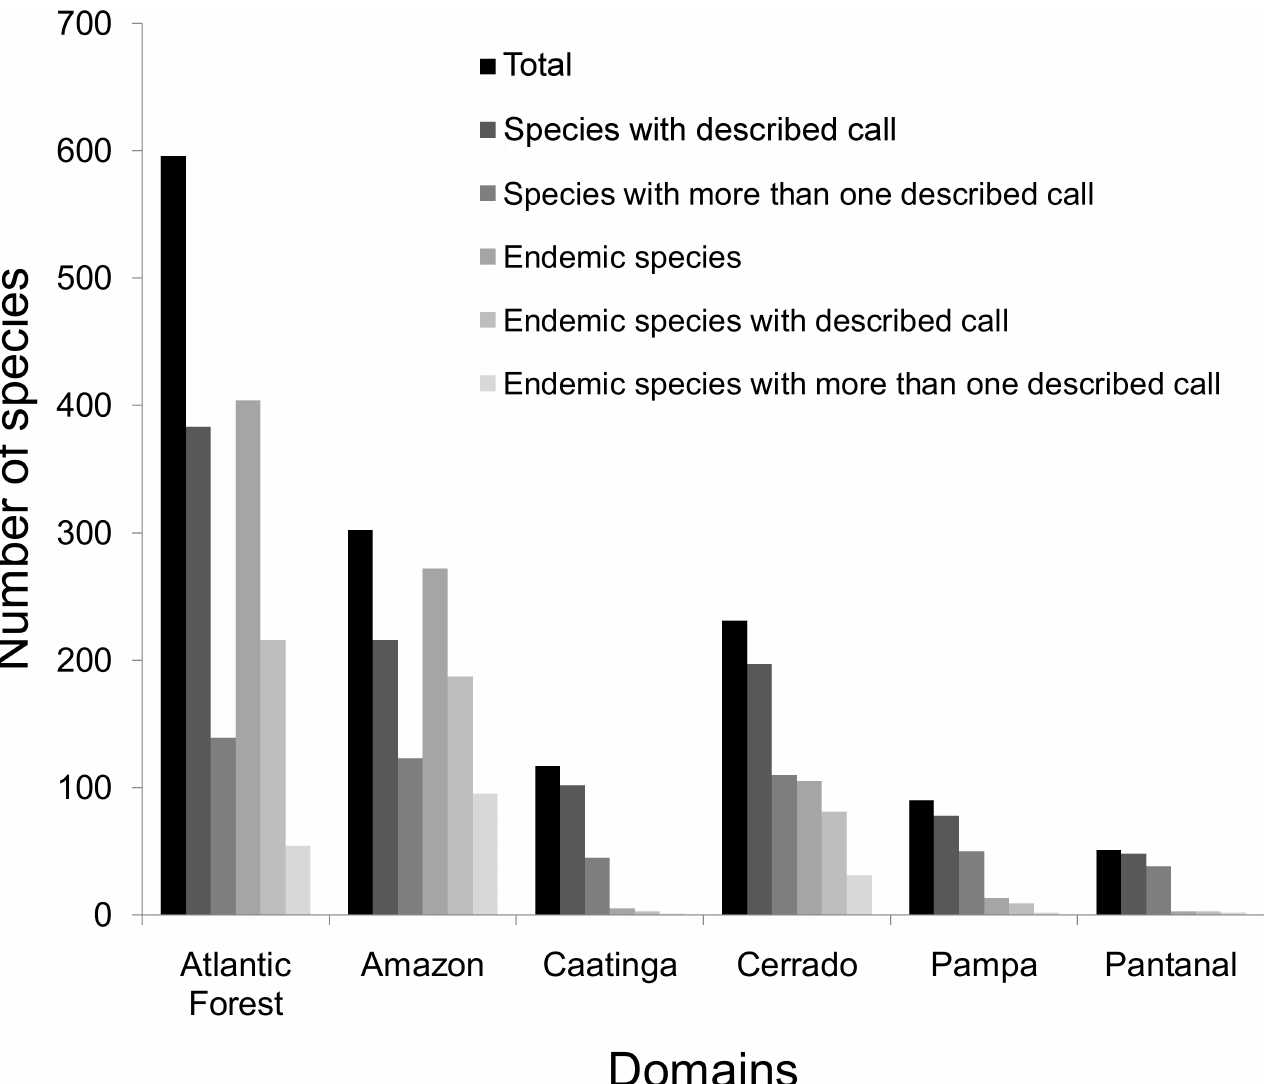
Fig 4. Number of anuran species (overall and endemic) in each Brazilian biome with one or more published descriptions of their advertisement call.